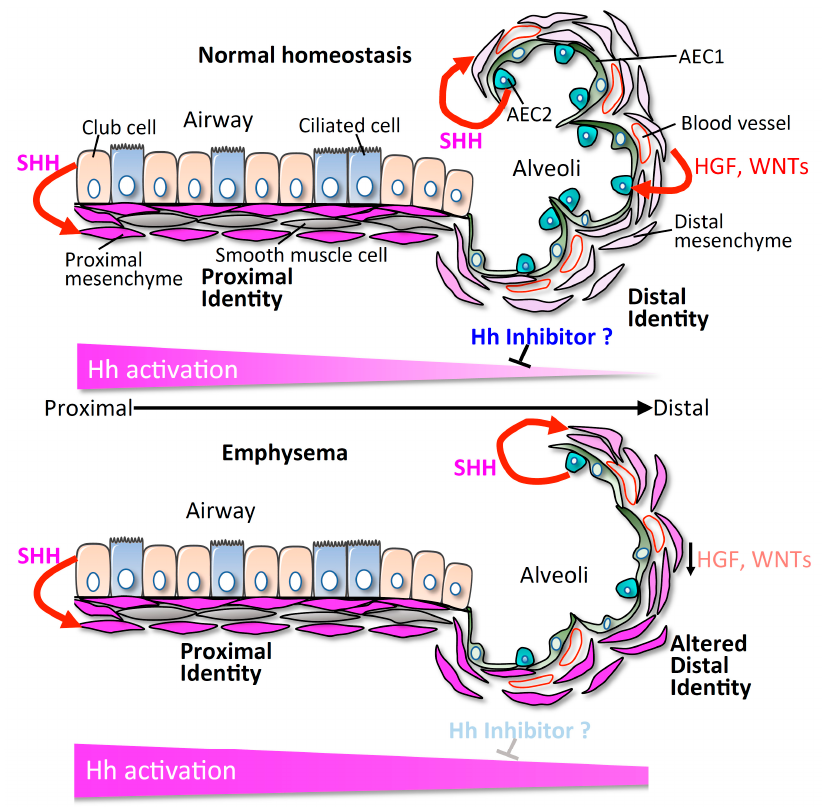
Figure 1. Model of asymmetric Hedgehog (Hh) activation maintaining discrete compartmental identity. We propose that differential activation of Hh is a possible mechanism in maintaining compartmental-specific identity and function in the lung. Loss of endogenous inhibitors of Hh activation could disrupt the physiological asymmetry of Hh, and lead to altered compartmental identity and structural alteration seen in lung diseases.